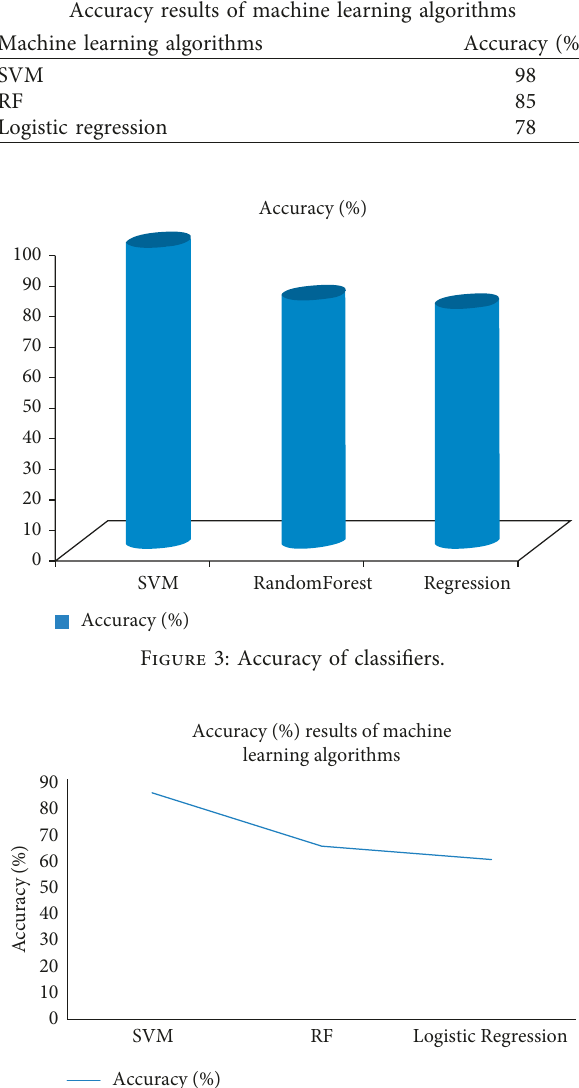
Figure 4: Graphical representation of the accuracy results of machine learning algorithms.